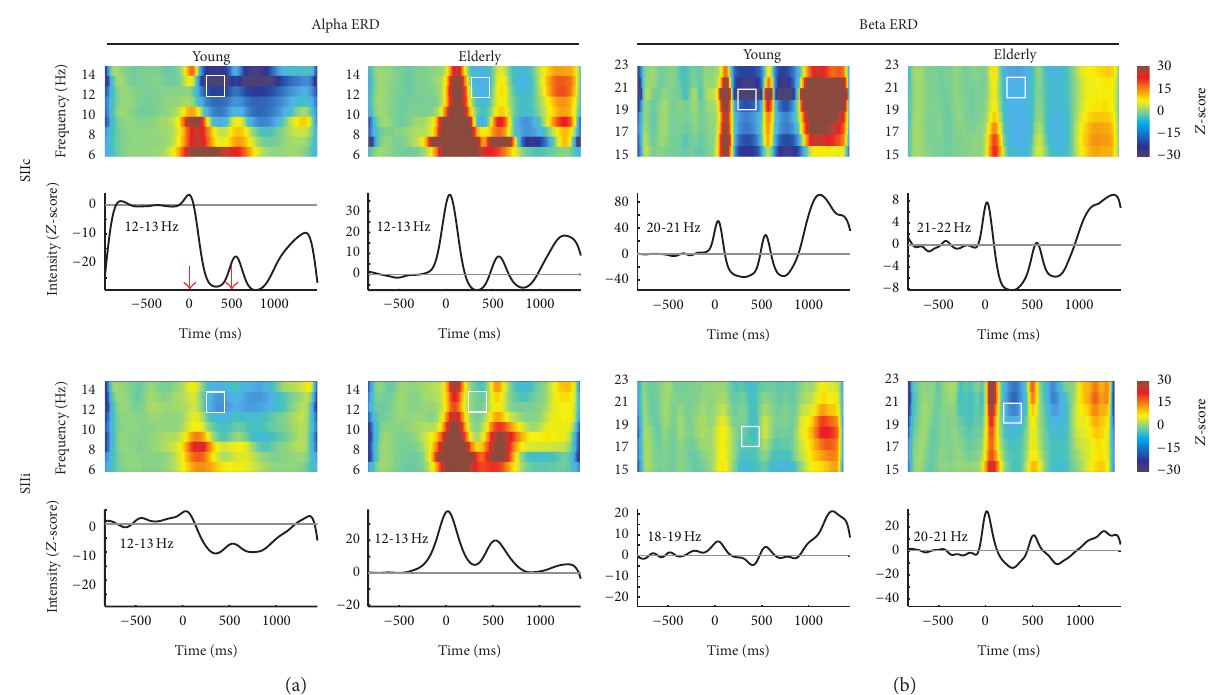
Figure 3: Time-frequency power analysis of the SIIc and SIIi for the alpha (a) and beta (b) frequency bands. The spectrograms between 6 and 14 Hz within alpha range and between 15 and 23 Hz within beta range are displayed. The plots below each time-frequency map exhibit the grand-averaged time course of event-related desynchronization (ERD) reactivity in the most reactive frequency bands (2Hz) with respect to baseline power. The red arrows correspond to the onset of electrical stimulation. The peak values of induced ERD following stimulus 1 (white squares) are extracted for the subsequent